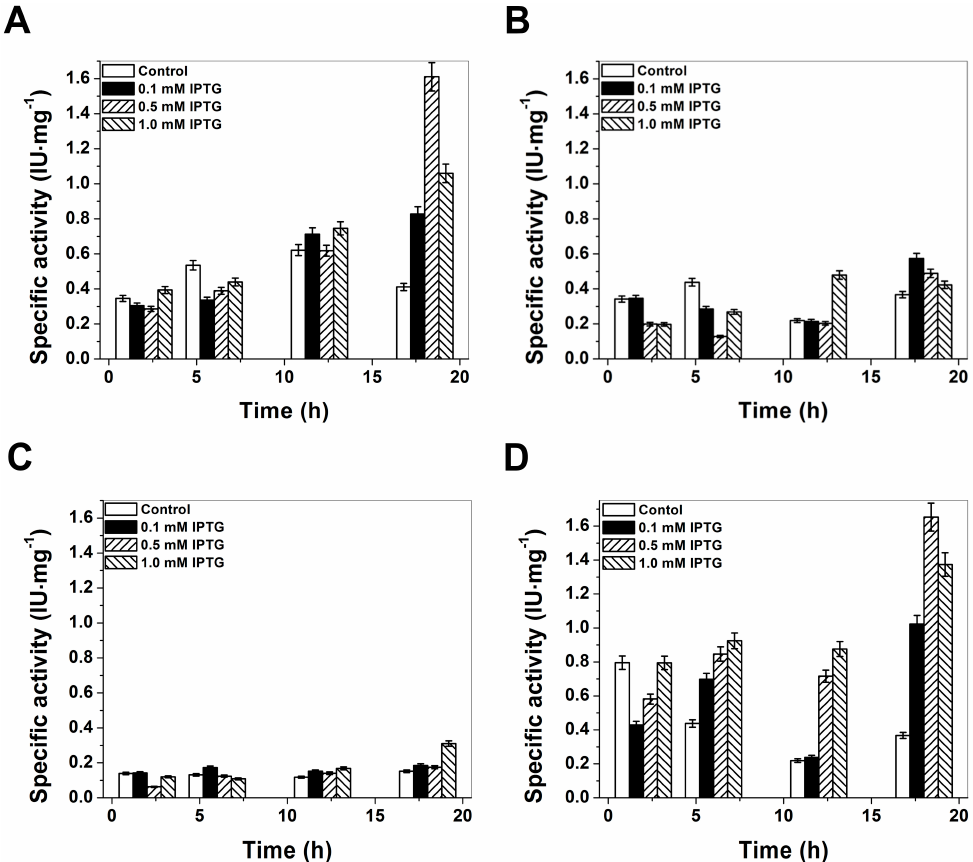
Figure 2. Heterologous expression of glucose-6-Phosphate Dehydrogenases (G6PDs) in Escherichia coli BL21(DE3) Δ zwf :: kan r : ( A ) expression of human WT G6PD; ( B ) G6PD Zacatecas; and two Class II mutants; ( C ) G6PD Vanua-Lava and ( D ) G6PD Viangchan. Sonicated cell were centrifuged, and the BL21(DE3)